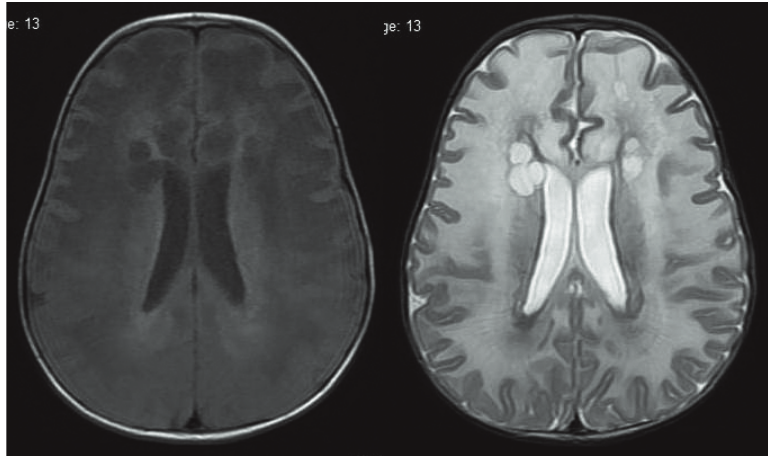
Fig. 2. T1W image (left) and T2W image (right) show a periventricular rim, hyperintense on T1W and hypointense on T2W, with cystic cavitation in the frontal periventricular